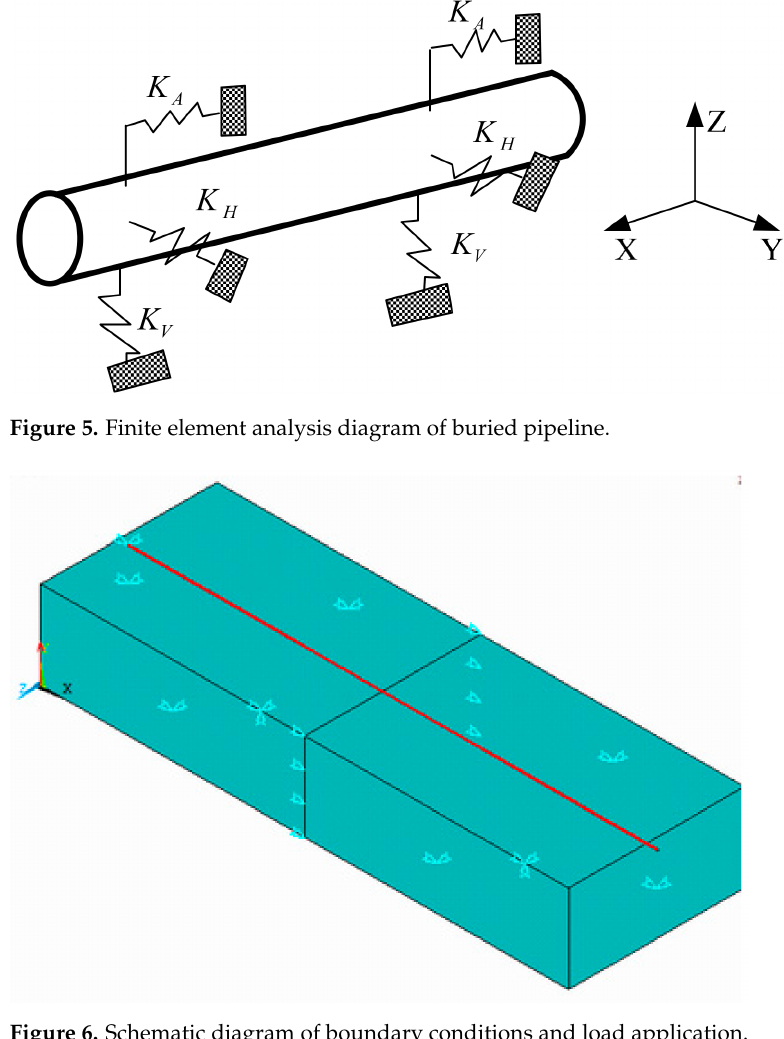
Figure 6. Schematic diagram of boundary conditions and load